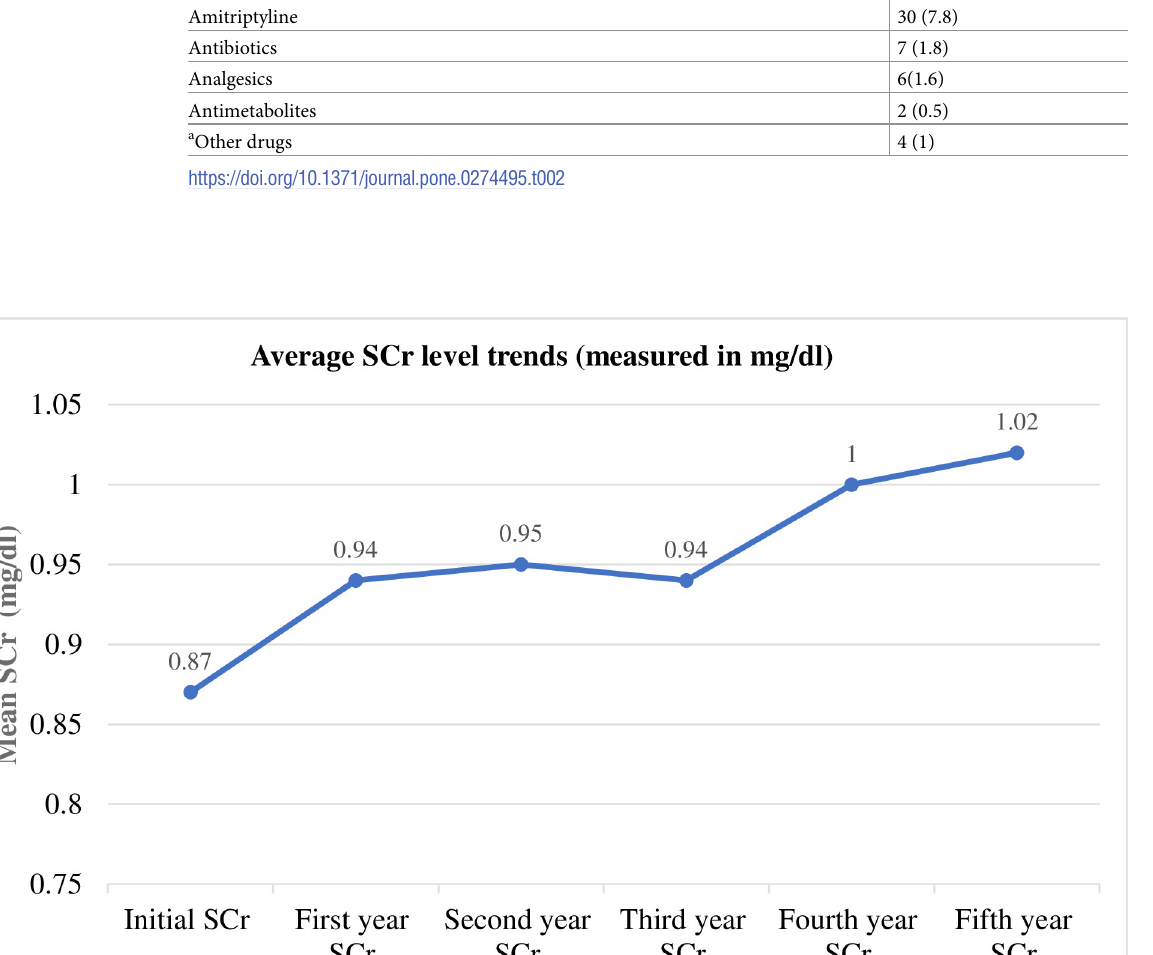
PLOS ONE | https://doi.org/10.1371/journal.pone.0274495 September 12,